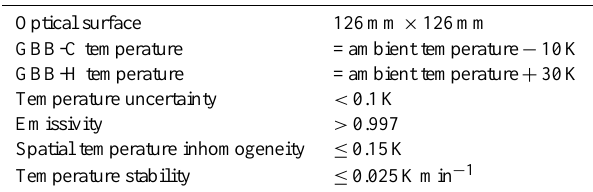
Table 1. Technical specifications for the GLORIA in-flight black- body calibration